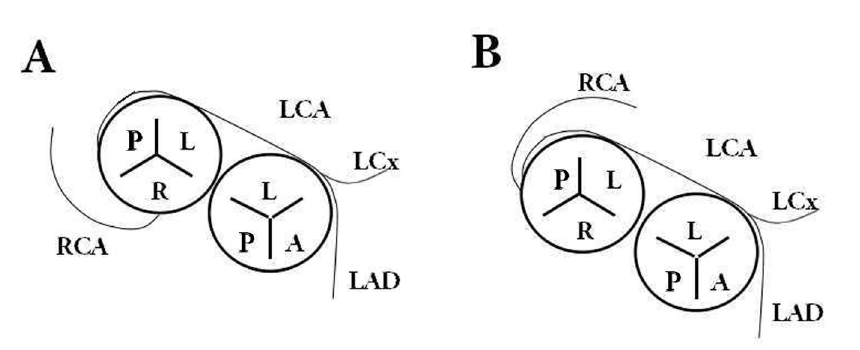
Fig. 3 - Coronary artery arising from the noncoronary sinus: (A) left coronary artery arising from the noncoronary sinus; and (B) both left and right coronary arteries arising from the noncoronary